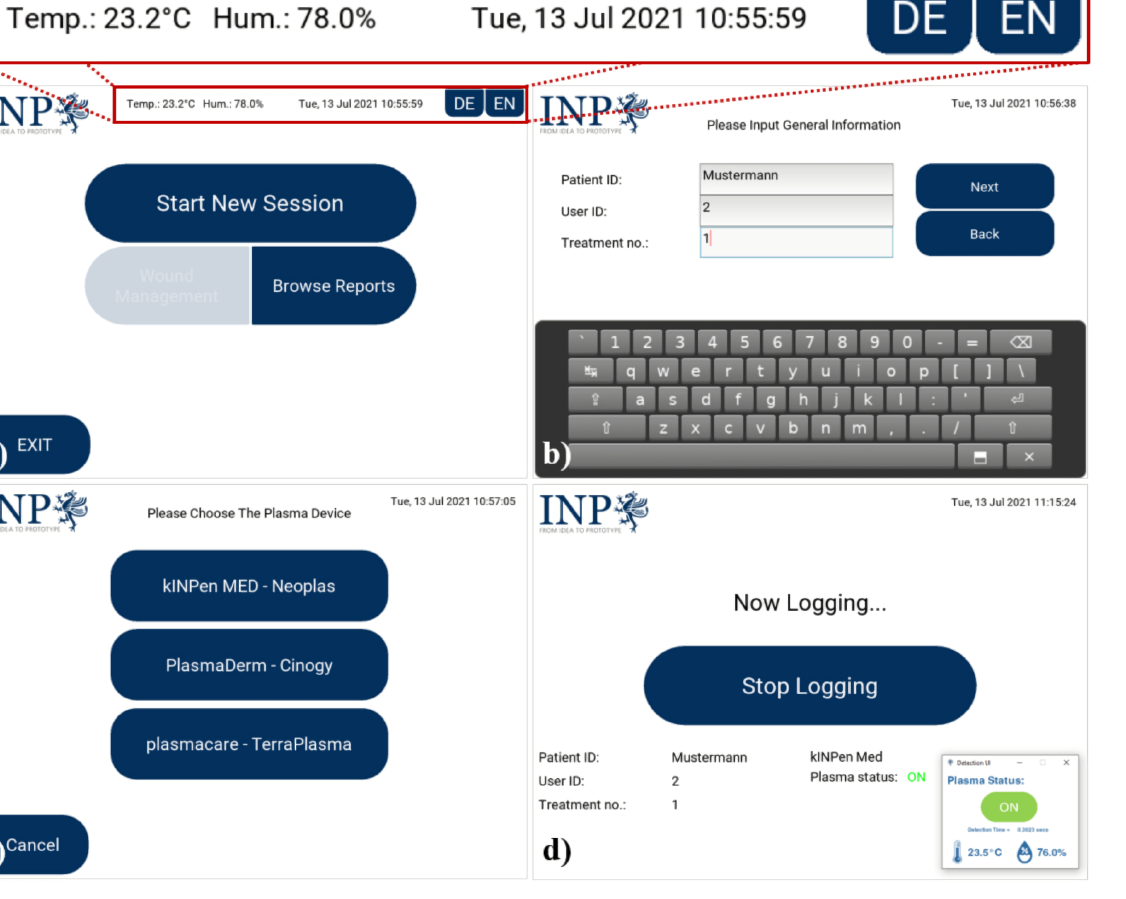
Figure 7. Example of the GUI screens (software version 0.3.0): ( a ) main screen, ( b ) general information input screen, ( c ) plasma source device selection screen, and ( d ) logging